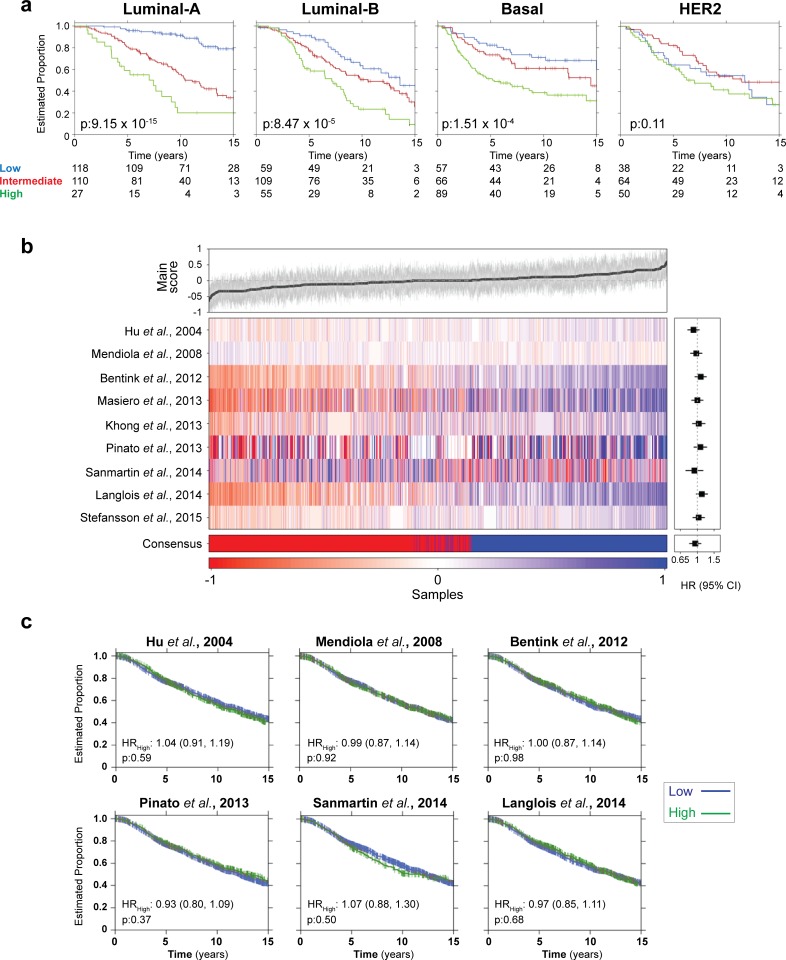
Breast cancer sub-types and comparison with other gene signatures.(a) Overall survival for each of the PAM50 subtypes was observed. Shown the Kaplan-Meier survival curves for Basal, Luminal-A, Luminal-B and Her2 subtypes. p-values were calculated using log-rank test. Six samples did not have a PAM50 class assigned and were excluded. Low-risk (more than 15 years), intermediate-risk (between 15 and 7.5 years) and high-risk (less than 7.5 years) (b) All nine previously published angiogenesis signature were assessed on METABRIC cohort. The heatmap shows the score between -1 and 1 for each sample (heatmap on center). Top plot depicts median score obtained from all nine signatures, gray lines highlight standard deviation. Bottom depicts consensus call of all nine signatures combined. On right, forest plot shows hazard ratio, lines represent 95% confidence interval. (c) Survival curves for 6 representative angiogenesis signatures. Groups were dichotomized based on signature score: high-risk (score greater than the percentile of events) and a low-risk (score less than or equal to the percentile of events).